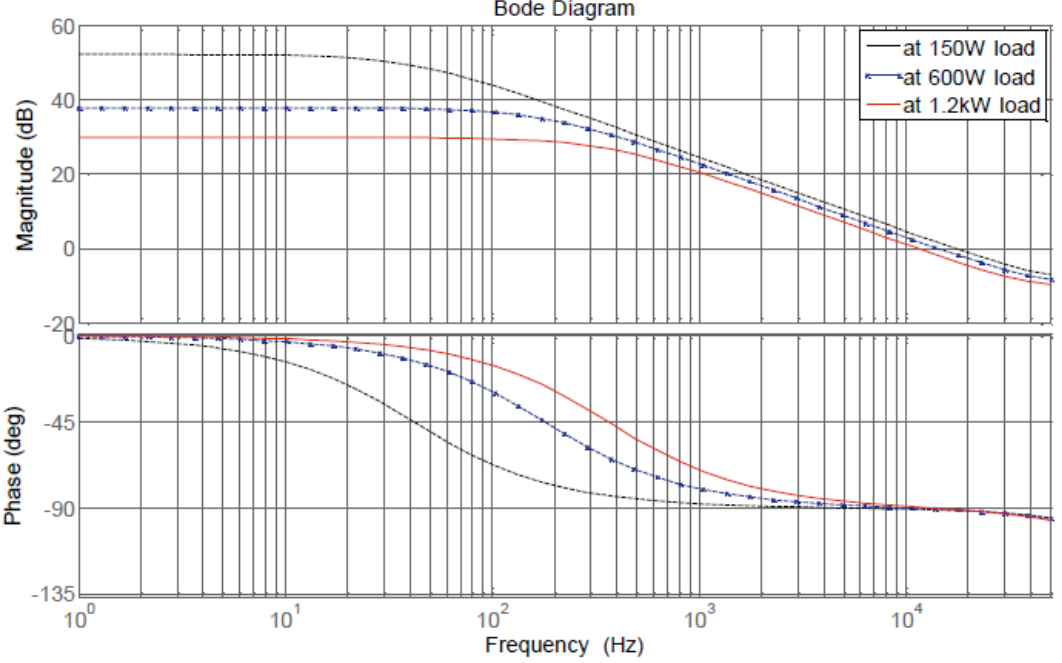
Figure 6. Open-loop Bode-plots of gain and phase for the power converter cell.